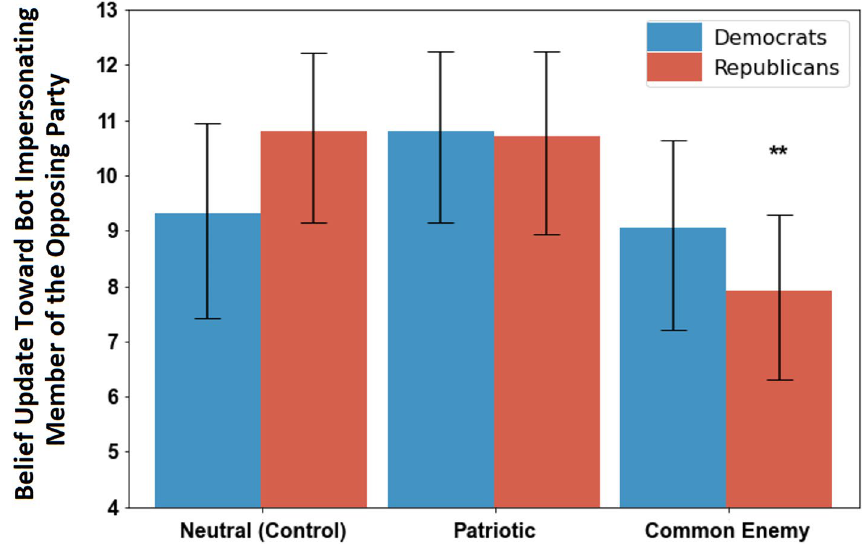
Figure 2. The extent that participants updated their beliefs toward the opinion of the bot impersonating a member of the opposing party during the collaborative online task, shown across experimental conditions and differentiated by political party. Vertical axis describes the post-stratified average belief update (in percentage points) for participants in each priming condition, where strata are defined by gender, political knowledge, the accuracy of initial guess, and awareness of bot’s membership in the opposing party. Larger values indicate that the participant updated their beliefs to become closer to the bot’s opinions, demonstrating greater receptivity to social influence from the other party. The neutral condition provides a baseline of comparison or a “control” condition. Error bars display 95% confidence intervals. **p < 0.01. See SI or description of our post-stratification